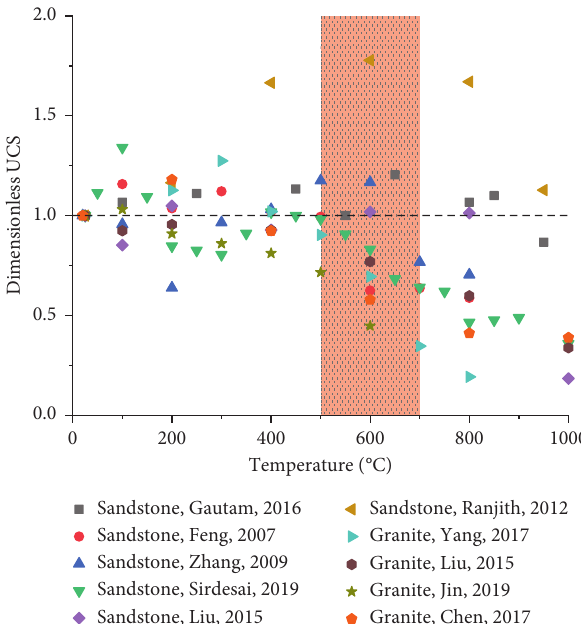
Figure 1: The relationship between normalized uniaxial com- pressive strength (UCS) and test temperatures, as reported in the